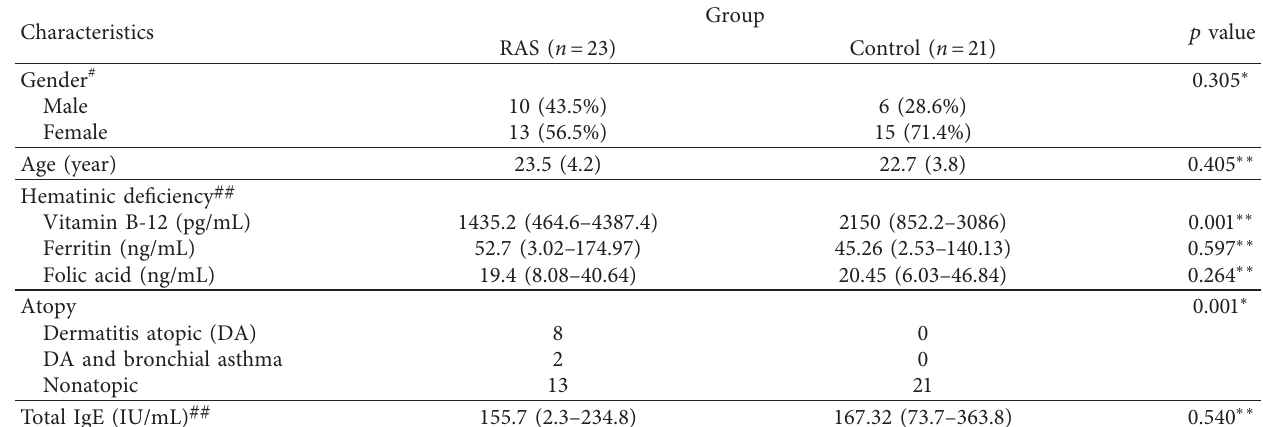
Table 1: Characteristics of subjects.